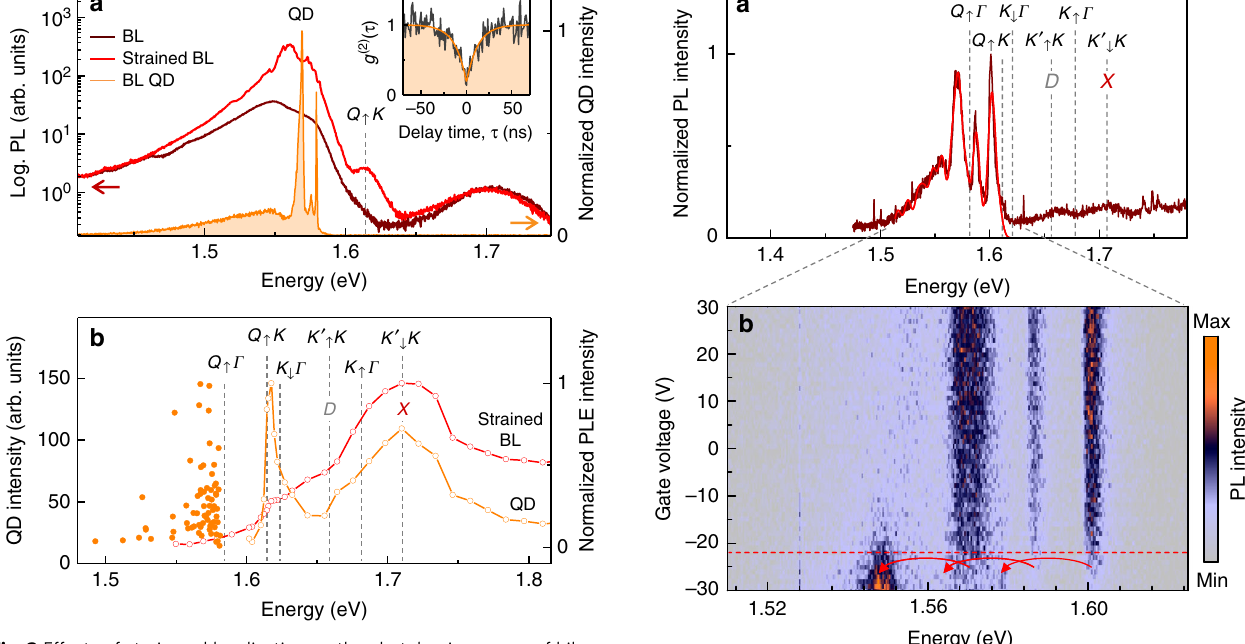
Fig. 3 Effects of strain and localization on the photoluminescence of bilayer WSe 2 . a Photoluminescence from a strained bilayer region without (red) and with (orange) spectrally narrow and intense quantum dot (QD) emission recorded at a factor of 1000 lower-excitation power. The bilayer spectrum away from strained regions (brown) is shown for reference. Note the strain-induced emergence of the shoulder at 1.615 eV labeled as Q ↑ K . Inset: typical second-order coherence of a single quantum dot with pronounced antibunching on ~10 ns timescale. b Distribution of quantum dot intensities as a function of their peak emission energies ( fi lled circles, extracted from the map of Fig. 1b), and photoluminescence excitation spectra of the quantum dot and strained bilayer emission in a (orange and red open circles, respectively). The dashed lines mark the energy positions of the relevant exciton states regions. The PL spectrum on a strained position features characteristic blue and redshifts of a few meV for the upper and lower PL peaks (compare red and brown traces in Fig. 3a) consistent with ~0.1% of tensile strain which lowers (raises) the CB energy minimum at K (Q) 59 . In addition, a shoulder at 1.615 eV, indicated by the dashed line in Fig. 3a, becomes apparent due to strain-induced brightening of this momentum-dark transi- tion 60 . The energy position of this shoulder reappears as a resonance in the photoluminescence excitation (PLE) spectrum of a strained BL spot (open red circles in Fig. 3b). The resonance, marked by the dashed line and assigned to Q ↑ K , is even more pronounced in the PLE spectrum of the QD from the same spot position (with the spectrum in Fig. 3a) shown by open orange circles in Fig. 3b. We note that the PLE spectrum is not QD speci fi c, it rather represents generic BL resonances in the PLE of QDs emitting at different observation sites with different energies (see Supplementary Fig. 3 for PLE spectra of other QDs).